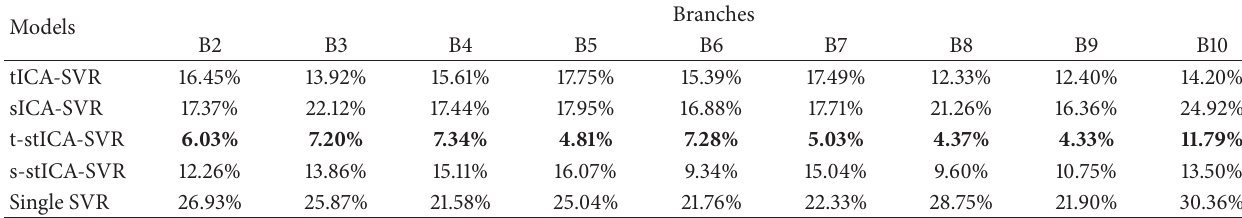
Table 7: Sales forecasting results of Branch 2 to Branch 10.